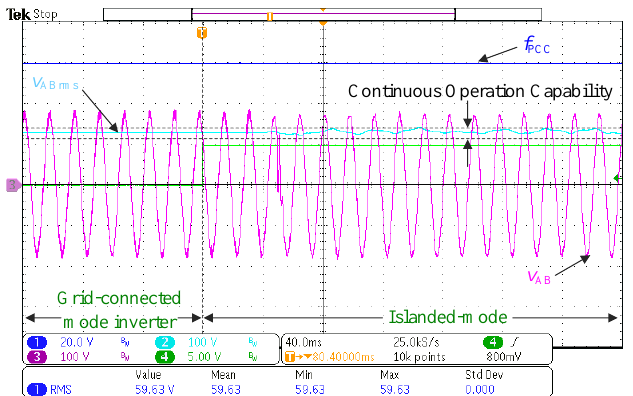
Figure 17. The transition from grid-connected mode to islanded operation mode on the